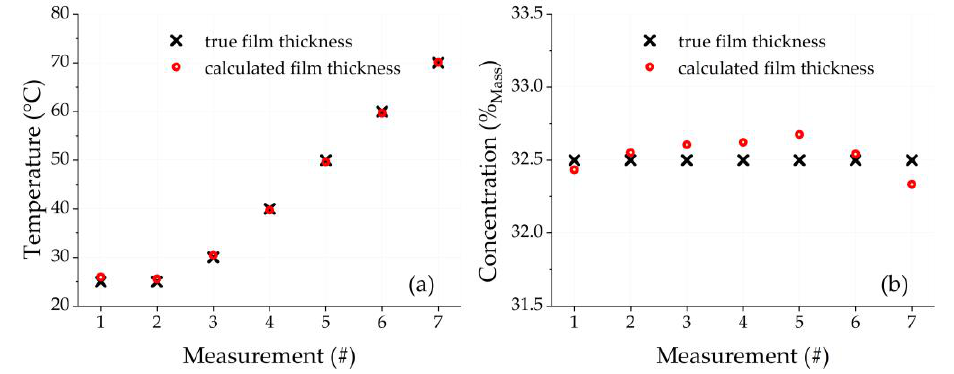
Figure 12. Results for calibration performed at ν 1 = 4253 cm −1 , ν 2 = 4808 cm −1 and ν 3 = 4501 cm −1 . ( a ) Red circles: true, predefined temperatures. Black crosses: calculated temperatures of test set. ( b ) Red circles: true, predefined concentrations. Black crosses: calculated concentrations of test set.